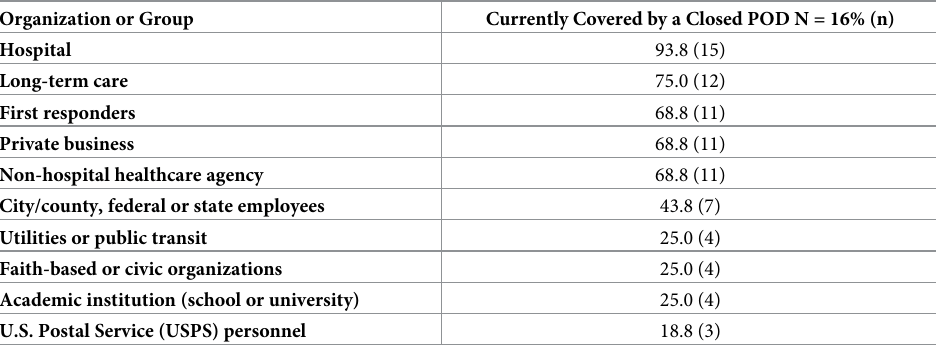
Table 2. Current jurisdictional closed point of dispensing (POD)